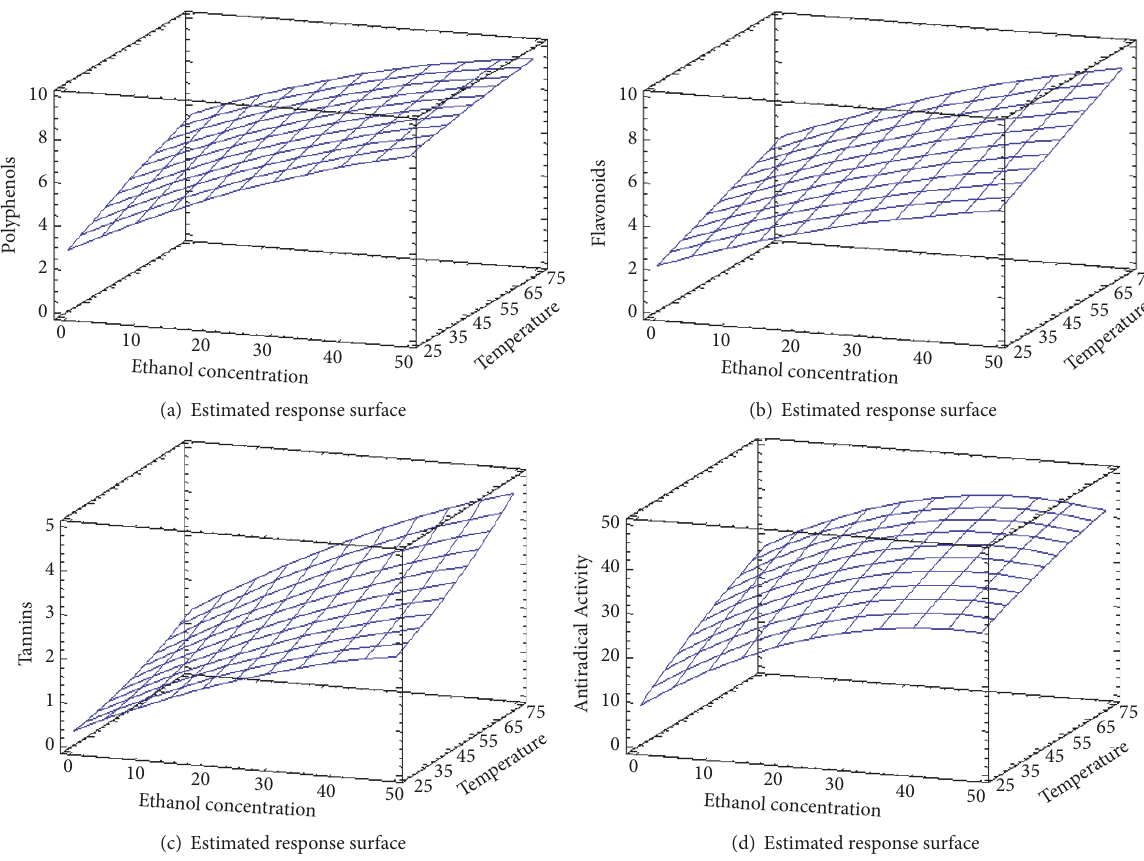
Figure 7: Polyphenols (a), flavonoids content (b), tannins content (c), and antiradical activity (d) surface plots. The three-dimensional graphs were plotted between two independent variables (temperature and ethanol